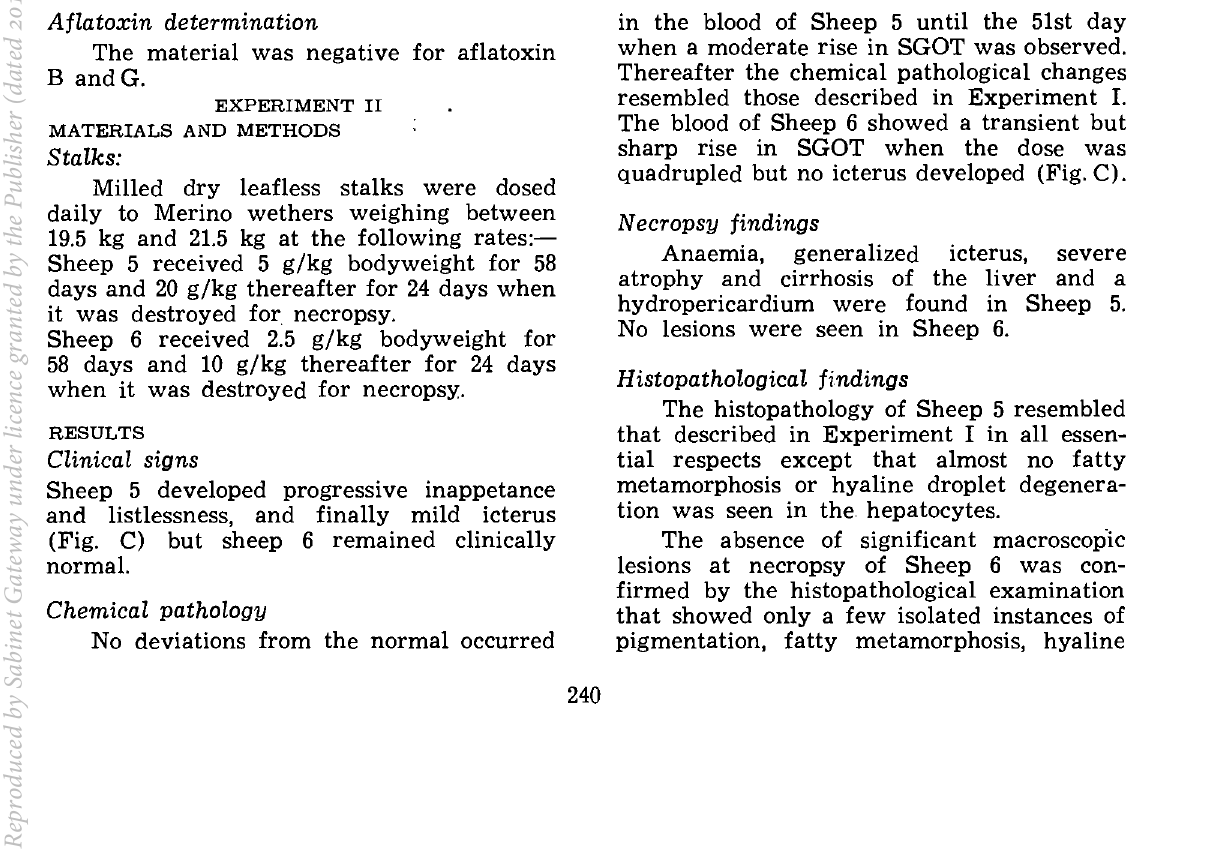
FIG. B Variations in the SGOT and plasma T. Br. levels of Sheep 2, Sheep 3 and Sheep 4. Aflatoxin